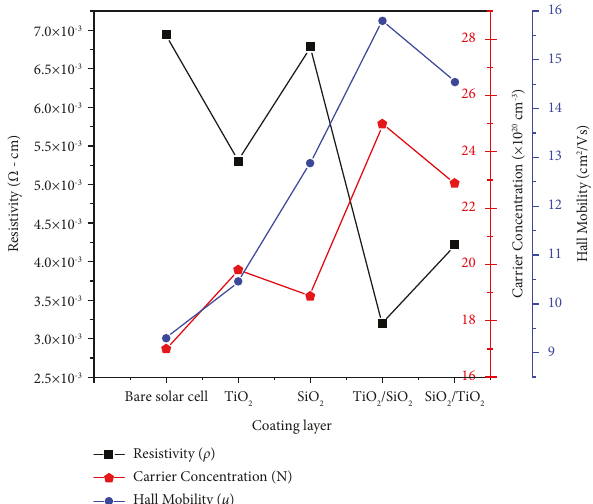
Figure 10: Electrical characteristics of uncoated and coated